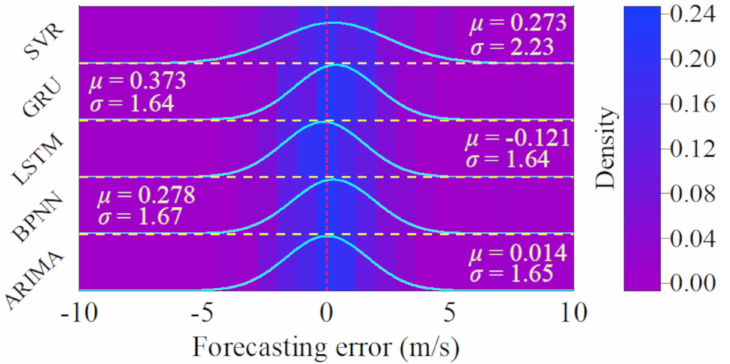
Figure 9. Density heatmap of forecasting errors.